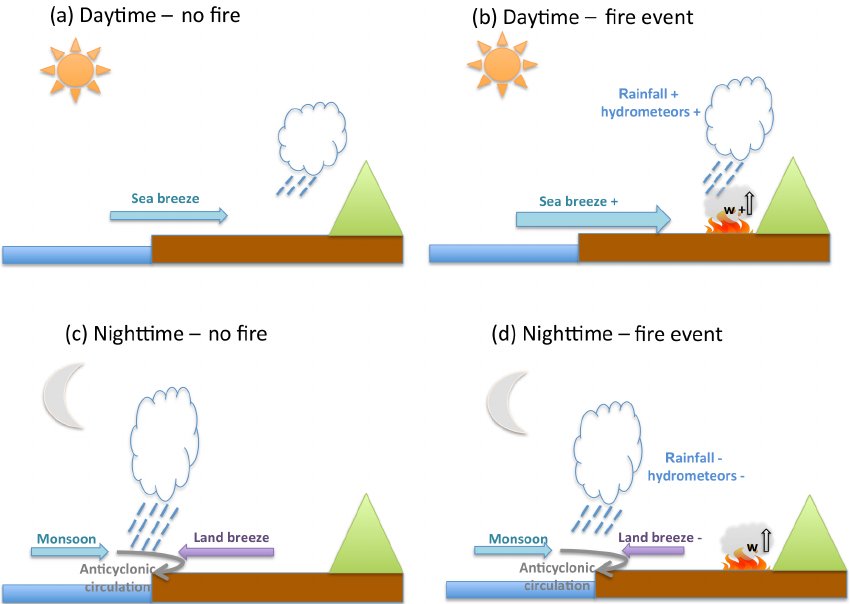
Figure 13. Schematics of diurnal rainfall and convection activity over western Borneo. Panels (a) and (b) illustrate the formation of convec- tion during the daytime without and with a fire event, respectively. Panels (c) and (d) are the same as (a) and (b) but for activity observed at